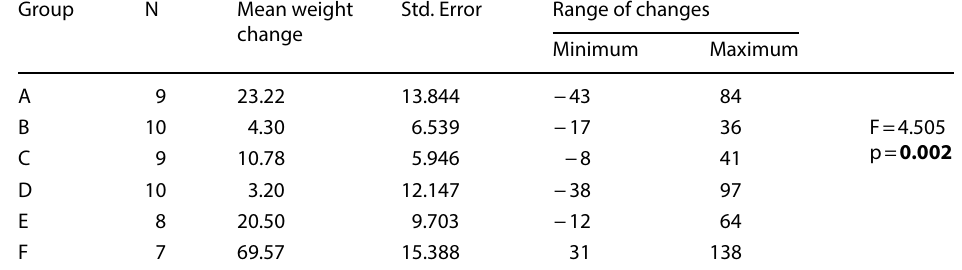
Fig. 1 Within Subject Effects: Estimated Marginal Means of weight over time. *Standard deviations are represented as black dashes (–) on the black vertical lines connecting the coloured